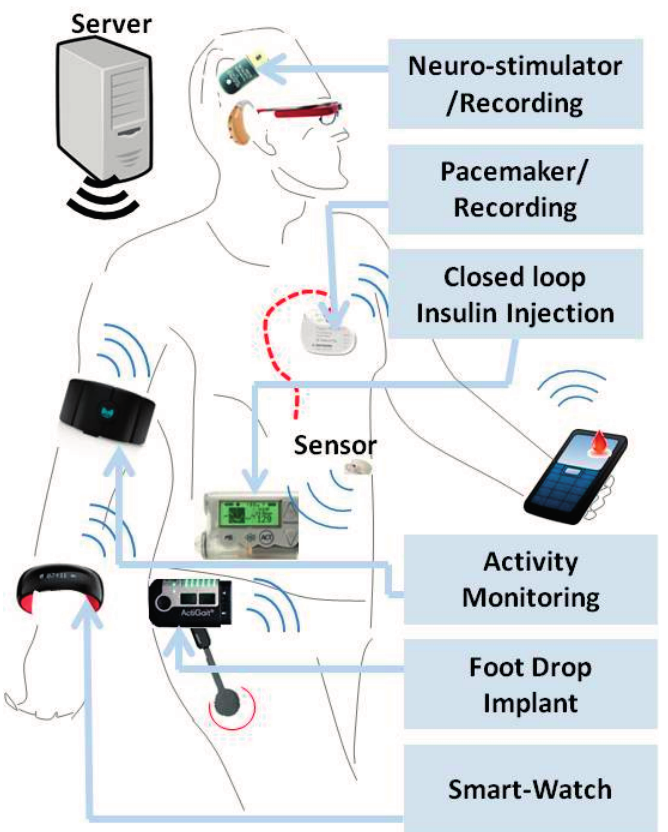
Figure 1. WBS technology for POC diagnostics of various diseases such as epilepsy, diabetes, foot drop using various implantable, wearable and handheld devices. These devices can be controlled by a base server through a wireless